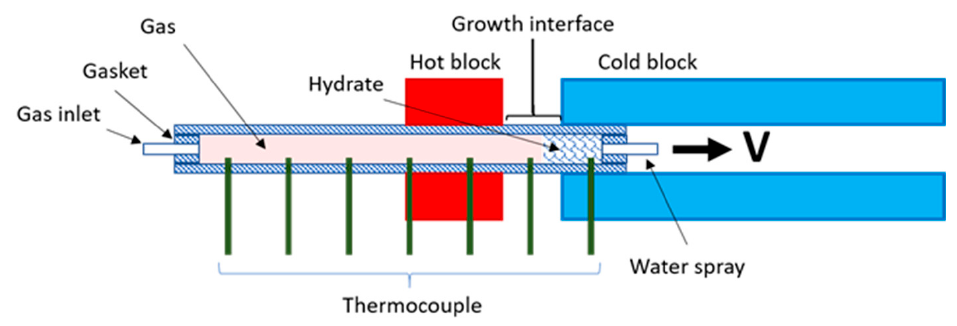
Figure 8. Schematics of unidirectional growth apparatus.